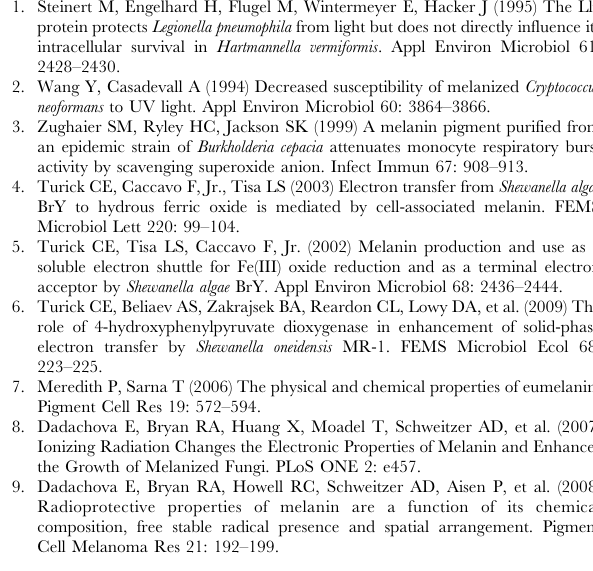
Figure S1 Optical spectra of melanin oxidation prod- ucts. A) supernatants collected from peroxide-treated melanized- cell ghosts and synthetic melanin; B) PDCA and PTCA synthesized from indole precursors, according to [12,24].